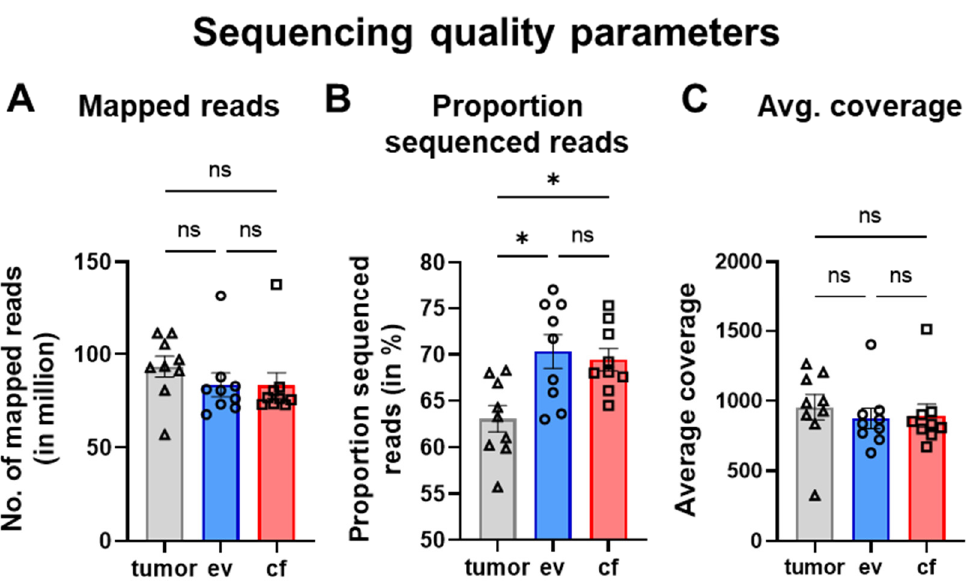
Figure 5. Quality parameters of sequencing data. ( A ) Number of mapped reads (in million). ( B ) Proportion of sequenced reads (in %). ( C ) Average coverage. Statistical tests: ( A – C ) Repeated-measures one-way analysis with Tukey multiple comparisons test; * p < 0.05; ns: no significant dif- ference.